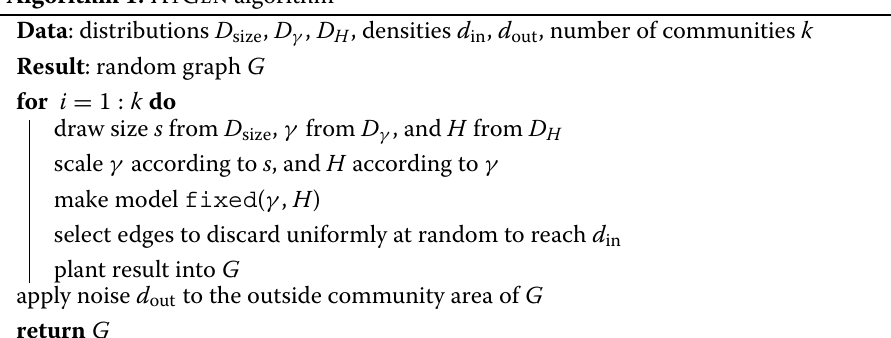
Algorithm 1: H Y G EN